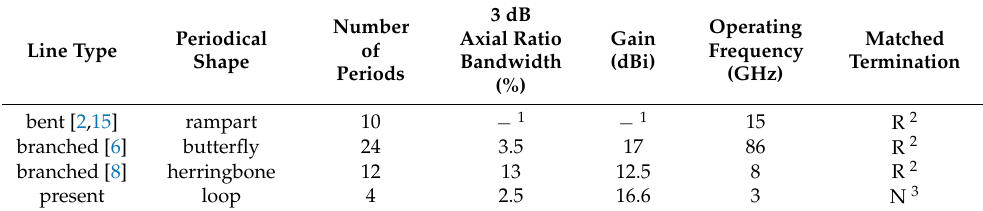
Table 1. Comparisons with line antennas of other research